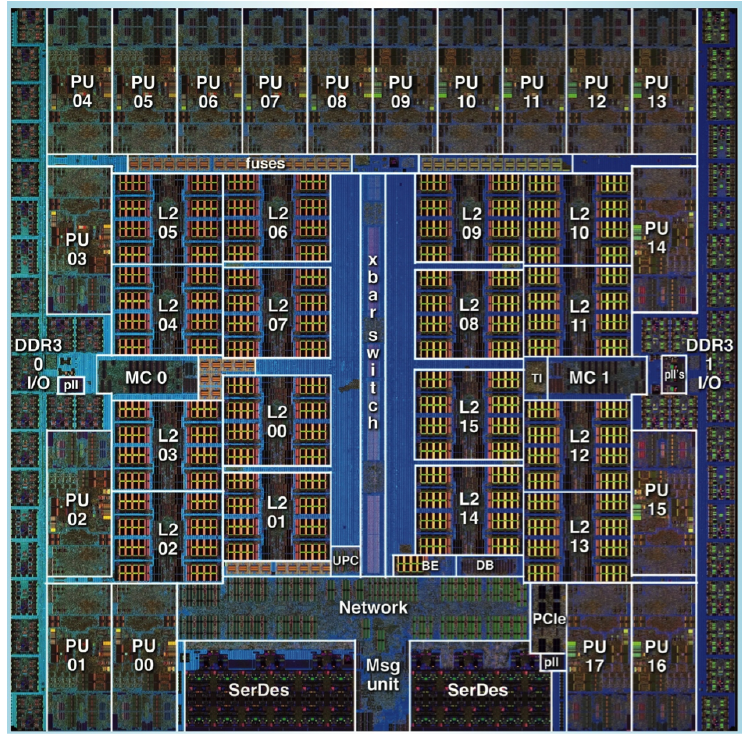
Figure 2: Physical layout of the Blue Gene/Q chip.